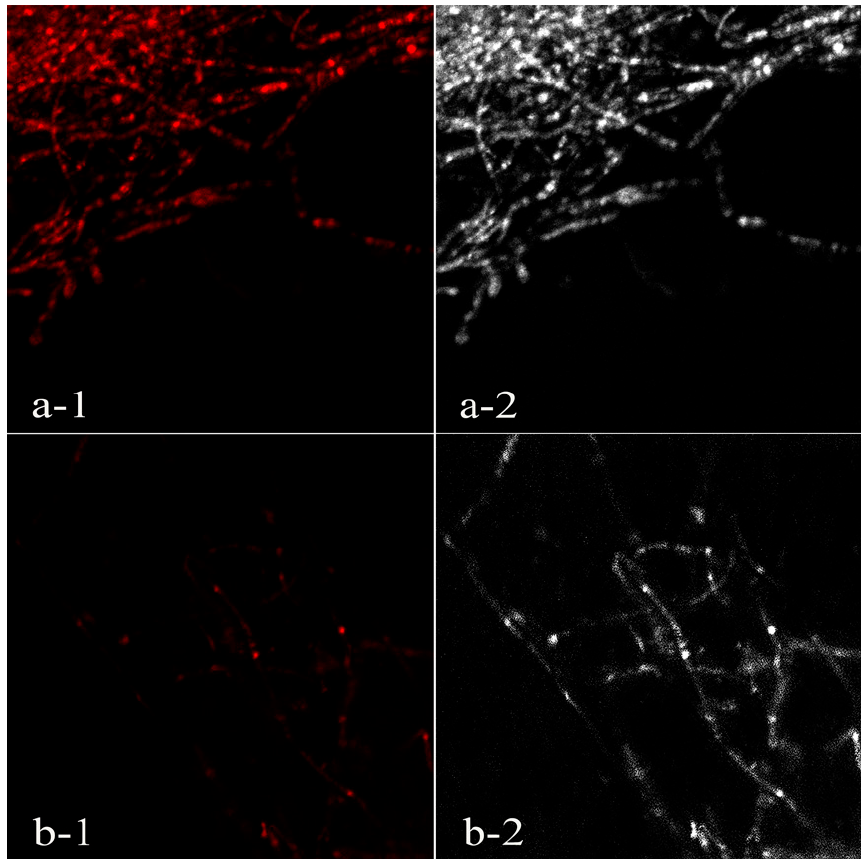
Figure 4. Effect of DADS on cell death of P. nicotianae. ( a-1 ) Mycelia treated with 450 μ L/L DADS Figure 4. E ff ect of DADS on cell death of P. nicotianae. ( a-1 ) Mycelia treated with 450 µ L / L DADS under the laser field; ( a-2 ) mycelia treated with 450 µ L / L DADS under ordinary light field; ( b-1 ) control under under the laser field; ( a-2 ) mycelia treated with 450 μ L/L DADS under ordinary light field; ( b-1 ) the laser field; ( b-2 ) control under ordinary light control under the laser field; ( b-2 ) control under ordinary light field.